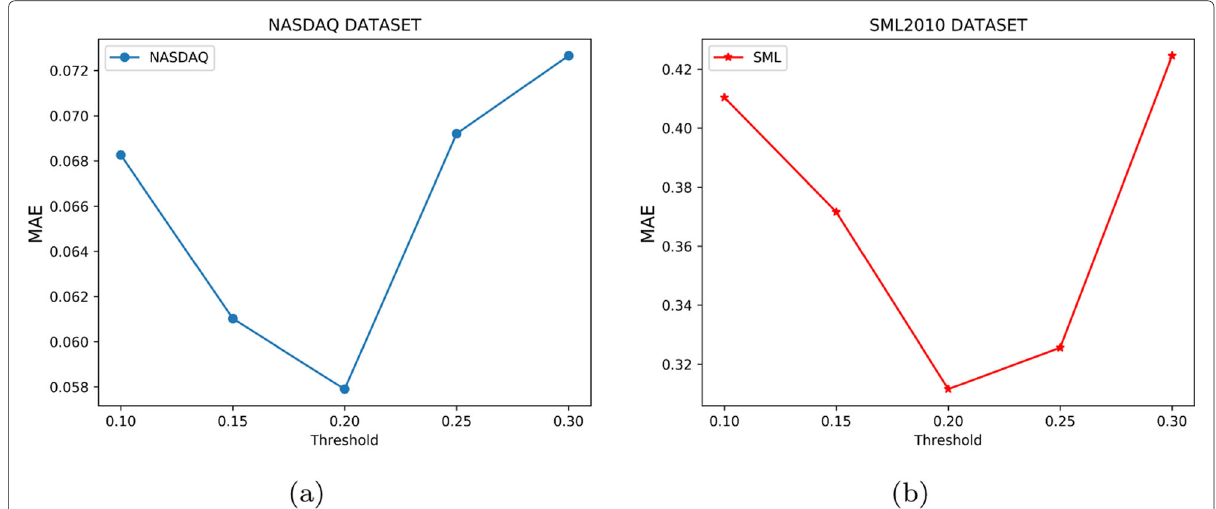
Fig. 6 MAE vs. clipping threshold over NASDAQ (a) and SML(b)